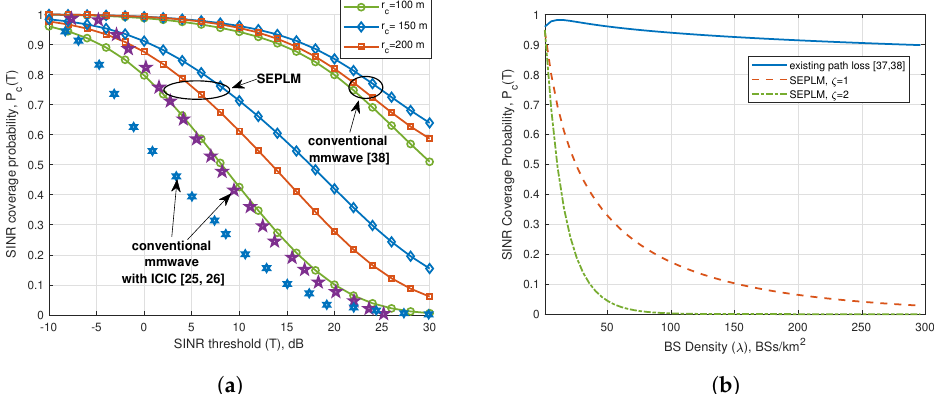
Figure 8. SINR coverage probability P c ( T ) comparison of conventional path loss model for mmwave and SEPLM. ( a ) SINR vs. SINR threshold (T) ( b ) SINR vs. BS density ( λ